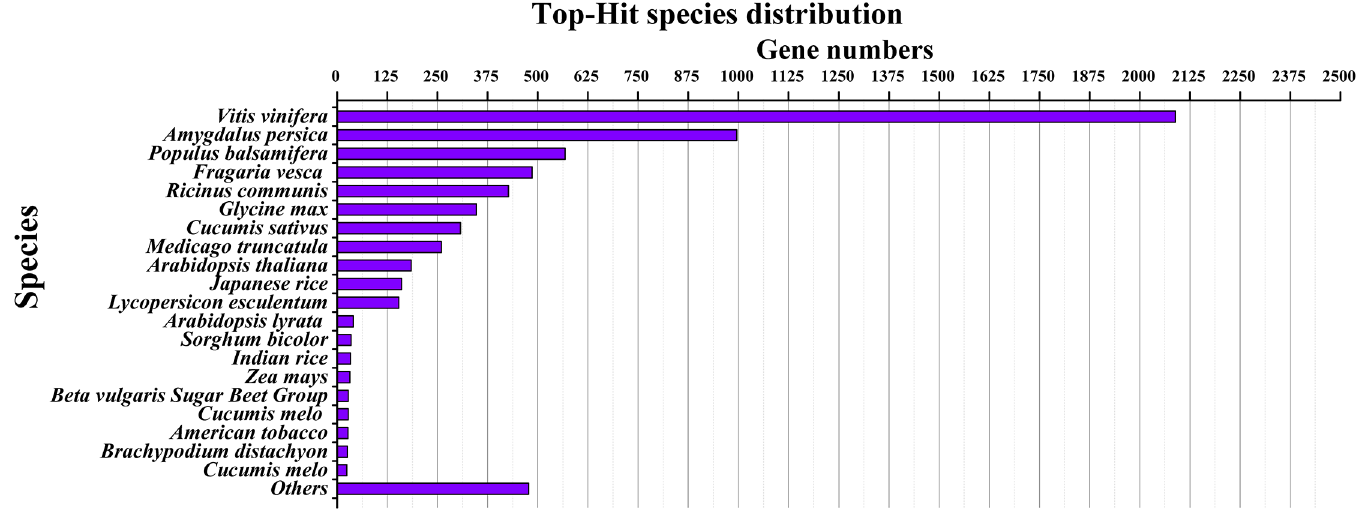
Fig 4. Top hit species distribution of M. rubra for BLAST result.